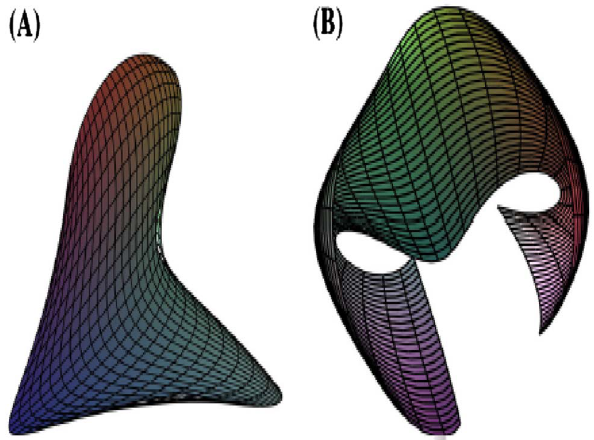
Figure 10. (A). The tubular surface K T ð s ; h Þ constructed by T . (B). The generalized tubular surface (cid:2) T ( s , h ) constructed by T